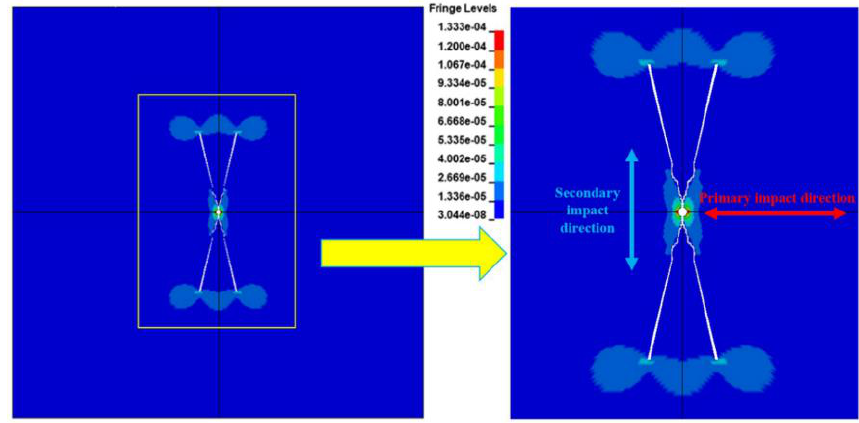
Figure 13. Crack propagation at impact reduction coefficient 0.7.